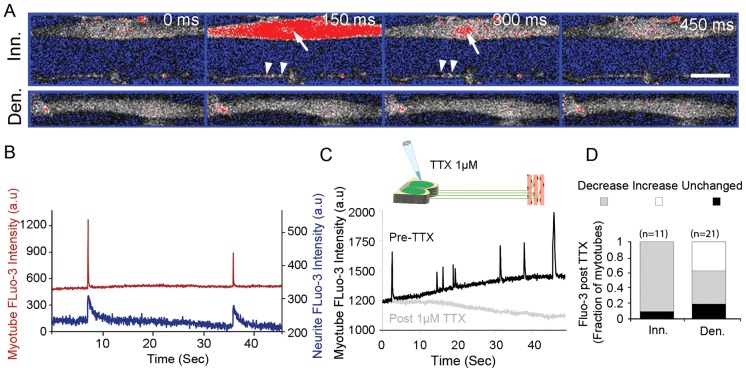
Ca2+ imaging of myotubes and innervating axons. (A) A correlated Fluo-3 transient in axon terminals and innervated (Inn.) myotubes. A representative timecourse of epifluorescent images was taken of a single spike (upper panel) with a 20× objective. Arrowheads and arrows mark signal spiking in the axon and myotube, respectively; lower images are of a non-innervated (Den.) myotube. Scale bar: 10 µm. (B) Representative time trace showing correlated Fluo-3 spiking in a neuron (blue) and an innervated myotube (red). a.u., arbitrary units. (C) Time trace of Fluo-3 signal in an innervated myotube pre- and post-TTX (1 µM) addition to the neuronal compartment. (D) The fraction of myotubes showing altered or unaffected levels of Fluo-3 signal spikes in innervated compared to denervated neurons after TTX treatment in the neuronal compartment.